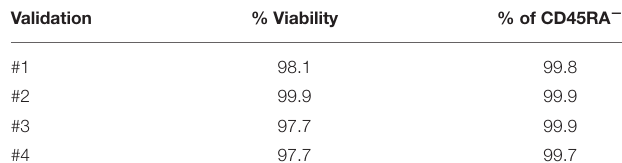
TABLE 1 | Purity and viability of CD45RA − starting cells.